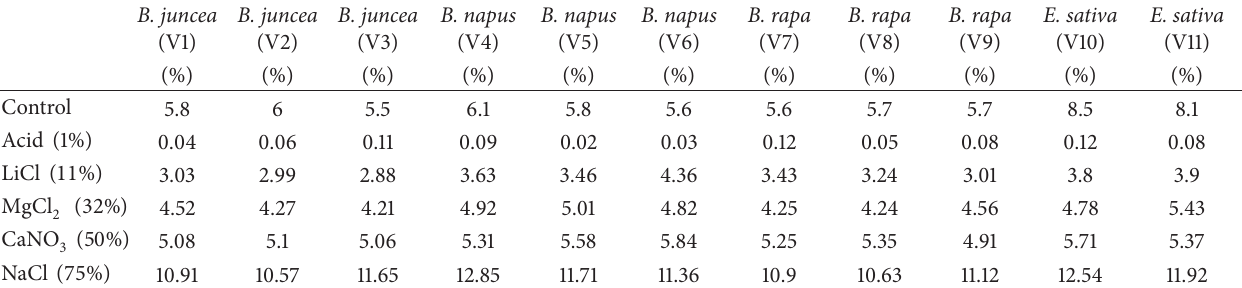
Table 1: Equilibration moisture contents of various accessions of Brassica spp. and Eruca sativa